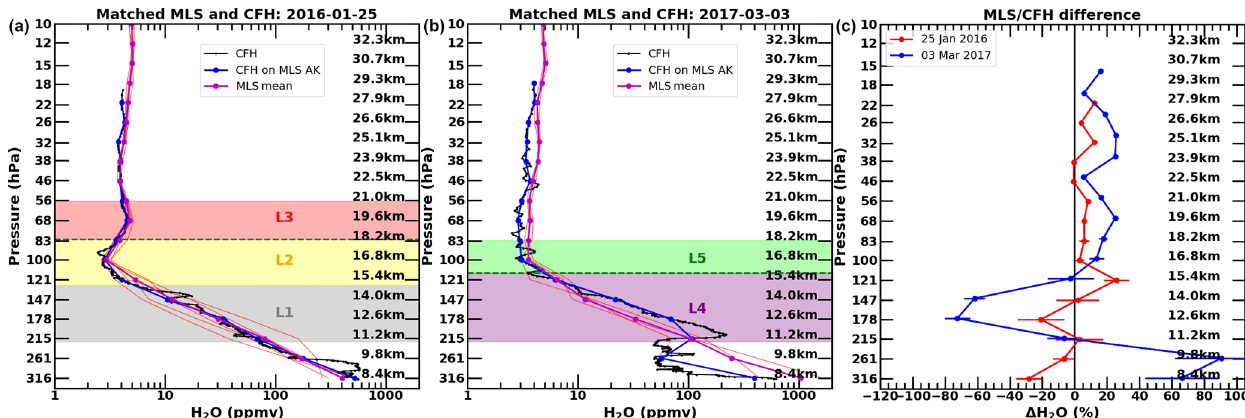
Figure 8. (a, b) High-resolution (black line) and convolved (blue line) CFH water vapor profiles and closest-matched MLS profiles (thin red line) on 25 January 2016 (five profiles) and 3 March 2017 (three profiles). The mean MLS profile for each date corresponds to the thick magenta line. The location of the cold point tropopause is indicated by the dashed green line. Important water vapor features are shaded and named. (c) Mean percent difference between the convolved CFH water vapor profile and MLS coincident profiles on 25 January 2016 (red line) and 3 March 2017 (blue line). The horizontal bars indicate twice the standard error of the mean percent difference. Markers for each pressure level on 3 March 2017 are slightly offset in pressure for clarity. Corresponding altitude values for MLS pressure levels are also shown in each